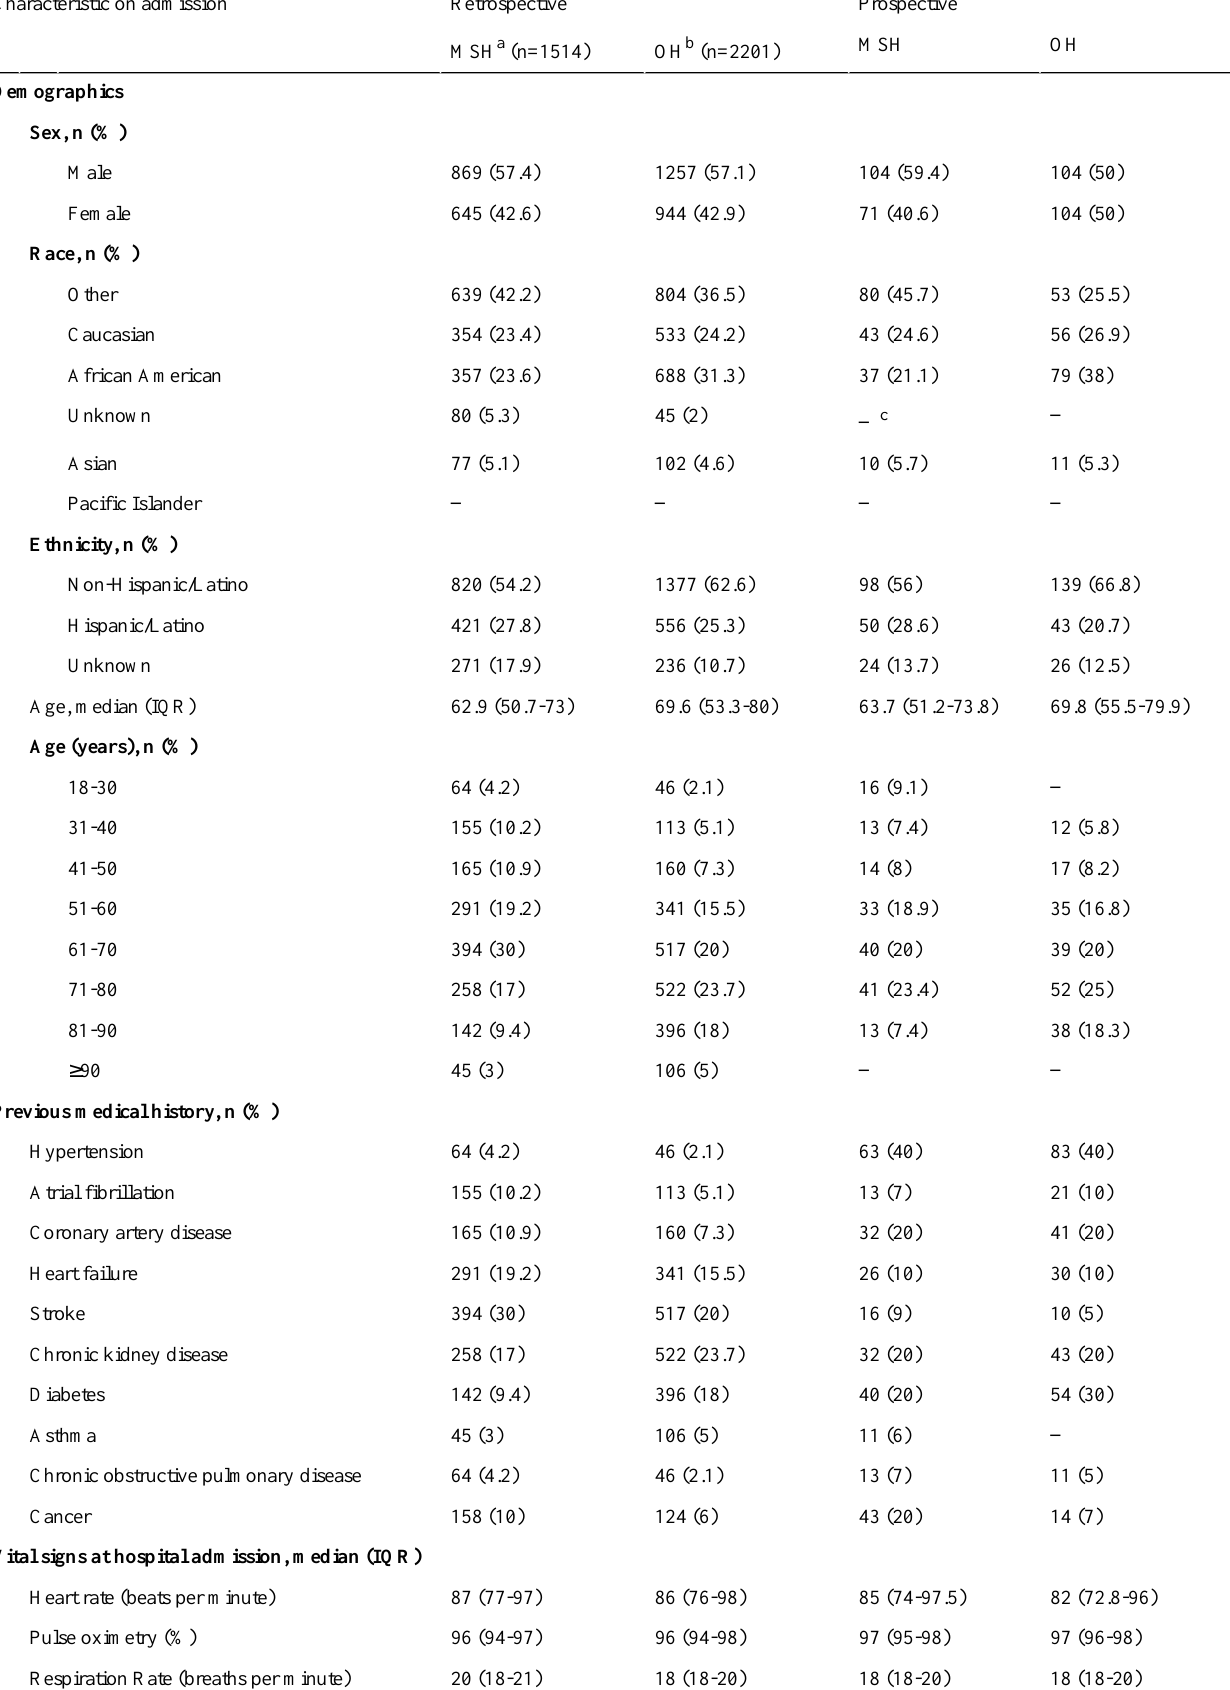
Table 1. Demographic characteristics, clinical history, and vital signs of hospitalized patients with COVID-19 at baseline (N=4098). ProspectiveRetrospectiveCharacteristic on